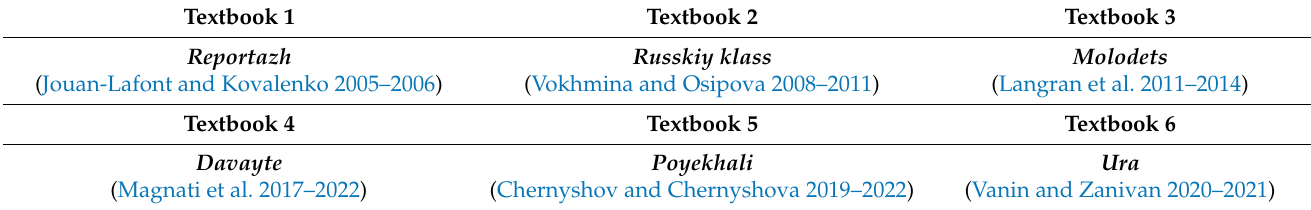
Table 1. Analyzed RFL textbooks for adolescent and adult learners in